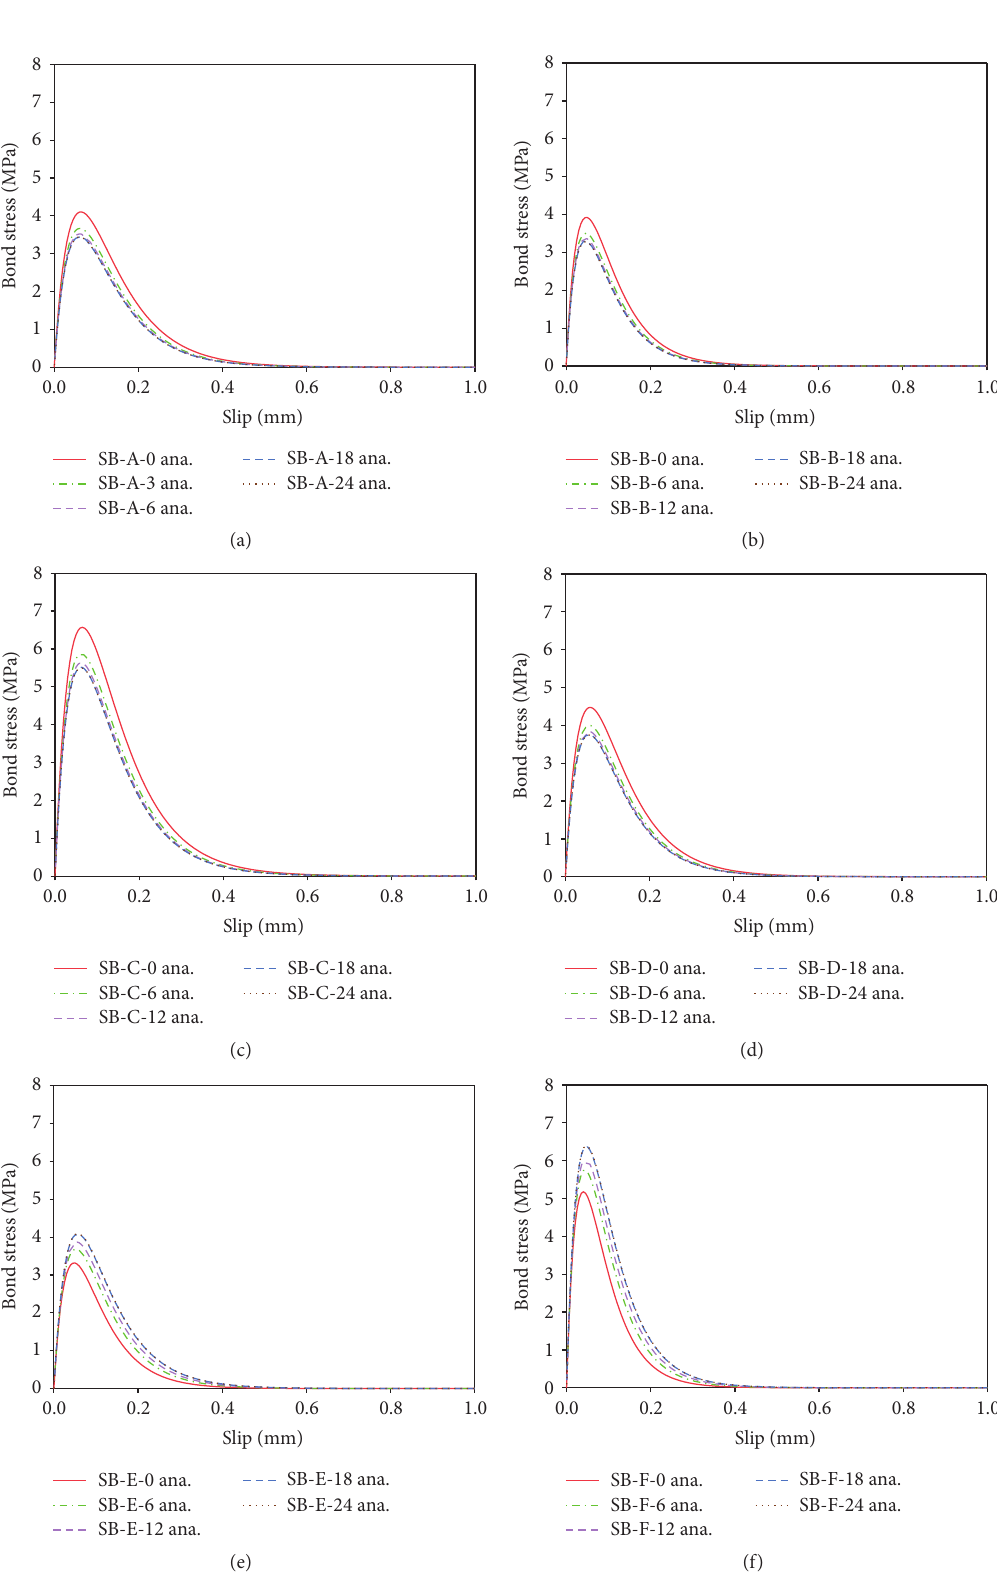
Figure 12: Modified bond-slip models incorporating moisture